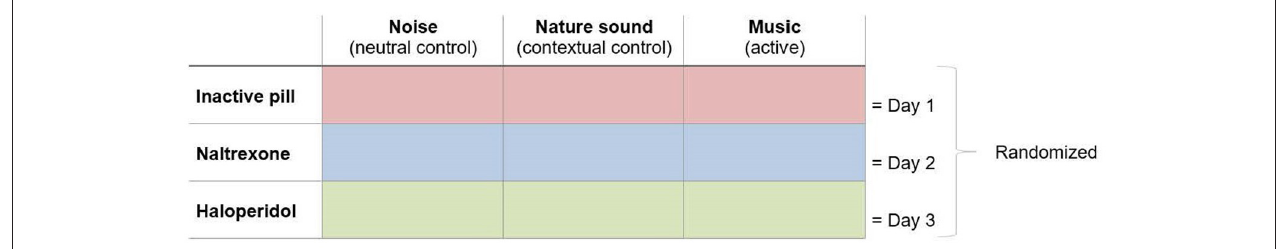
FIGURE 1 | Study design. On each test day, participants were exposed to individually calibrated pain stimuli while listening to noise, nature sound, and music in randomized order accompanied by administration of either an inactive agent, naltrexone, or haloperidol in a double-blind, randomized